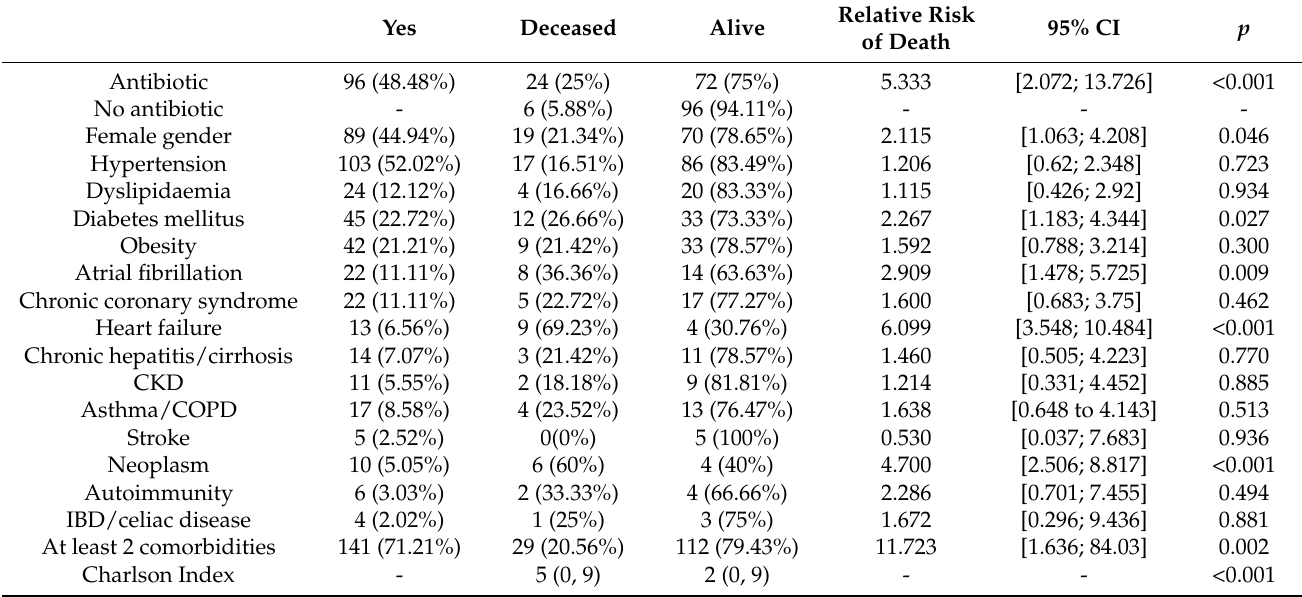
Table 1. Medical history data and its impact on mortality.